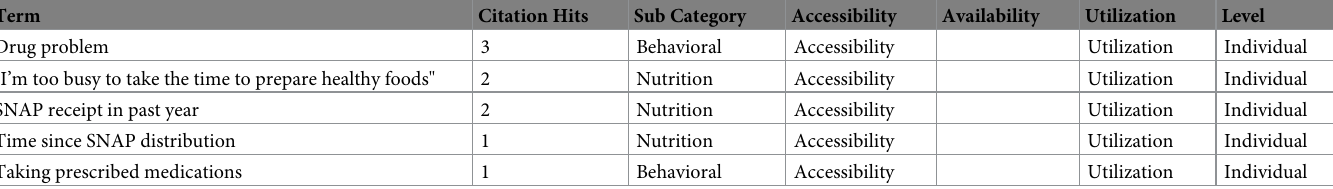
Table 3. Behavioural risk factors mapped to the dimensions of food